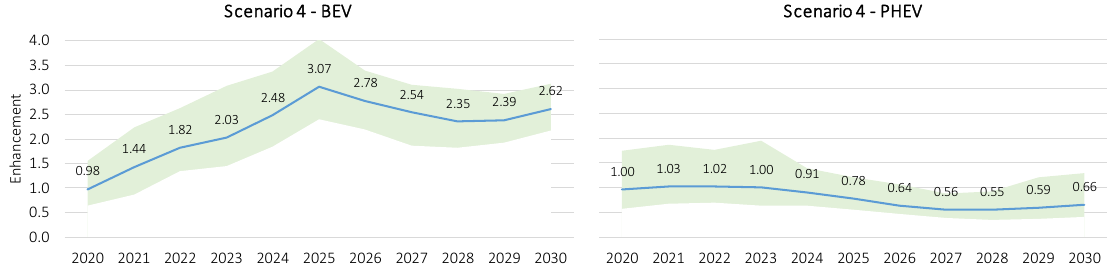
Figure 7. Simulation results for the different scenarios (BEV and PHEV separated).